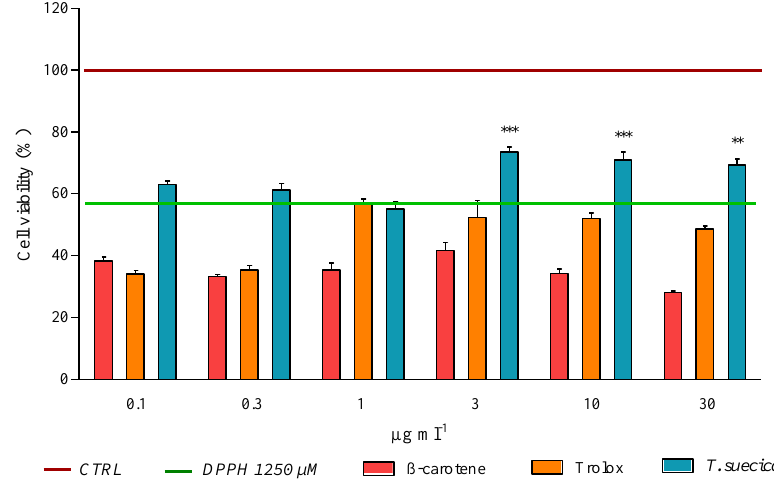
Figure 7. Scavenging activity of β-carotene, Trolox and Tetraselmis suecica extract on PNT2 cells injured with DPPH (at IC 50 concentration, 1250 µM). Cells were pre-treated with different concentrations of β-carotene, Trolox and T . suecica extract (0.1, 0.3, 1, 3, 10 and 30 µg mL −1 ). After 1 h, DPPH was added to each well. Cell viability were determined after 24 h, by using MTT assay. The results are expressed as percent of cell viability calculated as the ratio between the mean absorbance of each treatment and the mean absorbance of the control. The red bar (at 100% of cell viability) represents untreated cells (CTRL); the green bar (at 57% of cell viability) represents PNT2 treated with only 1250 µM of DPPH (DPPH 1250 µM). All values are represented as the means ± SD of three independent experiments. Asterisks indicate the statistically significant difference compared to the positive control with DPPH (** p ≤ 0.01, *** p ≤ 0.001; Dunnett’s test).